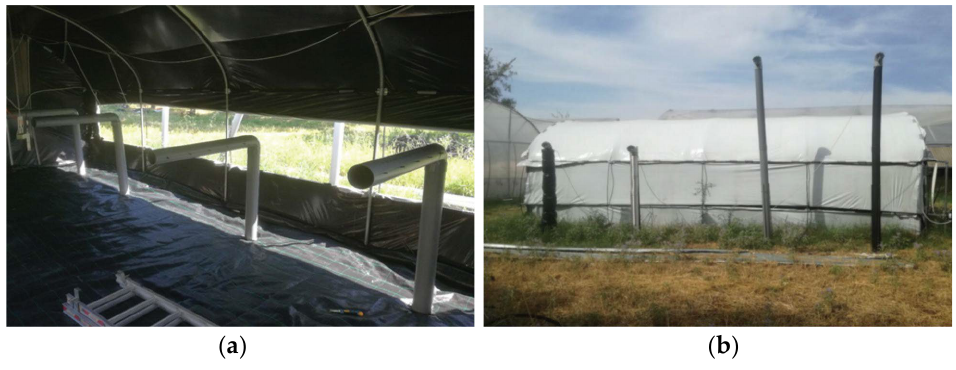
Figure 3. Drying tubes, ( a ) internal view and ( b ) external view. Table 2. Description of drying tubes.